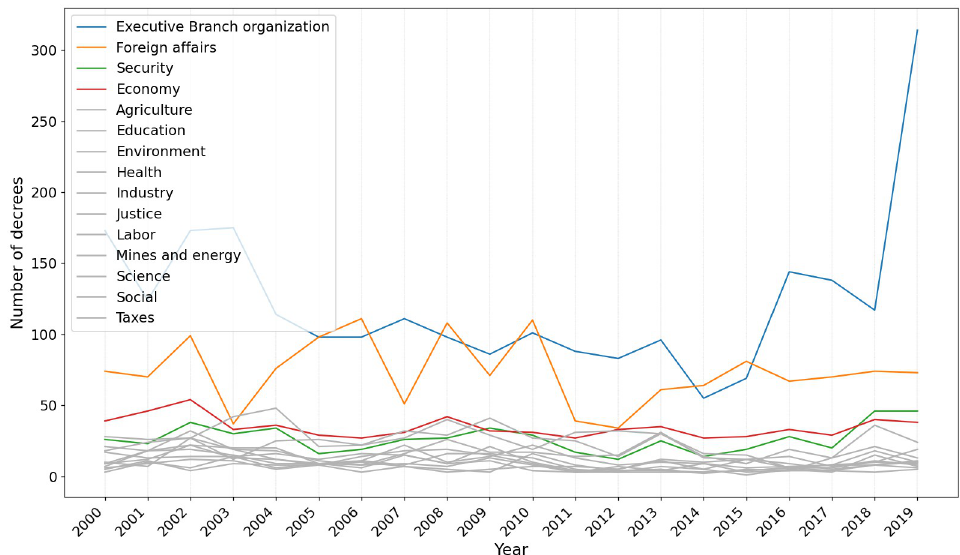
Fig 9. Number of decrees per year from the perspective of the Senate-based taxonomy focusing on the top 4 areas most issued in 2019.